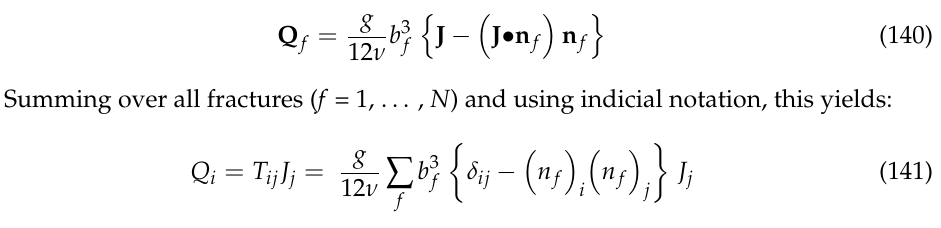
Figure 25. Schematic of a fracture network made of two sets of equally spaced and parallel fractures.